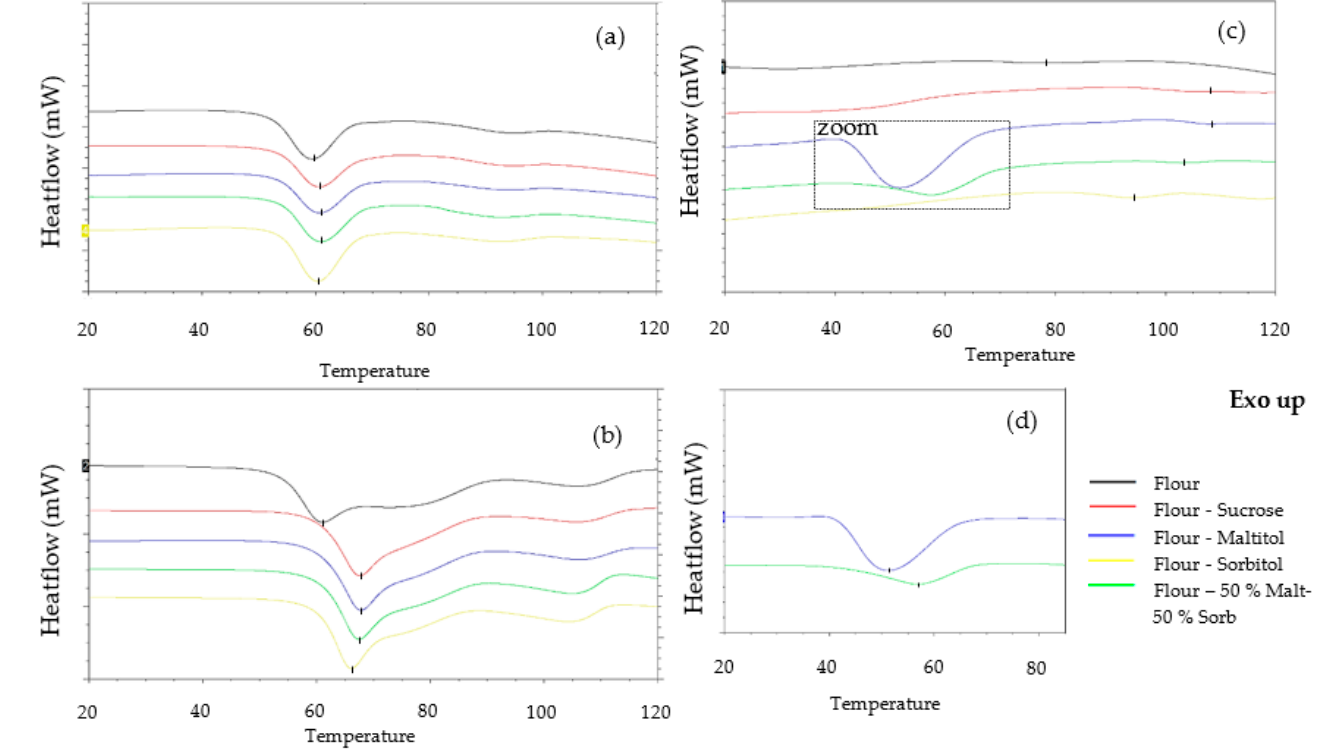
Figure 9. Representative DSC thermograms of model systems at different water contents. ( a ):